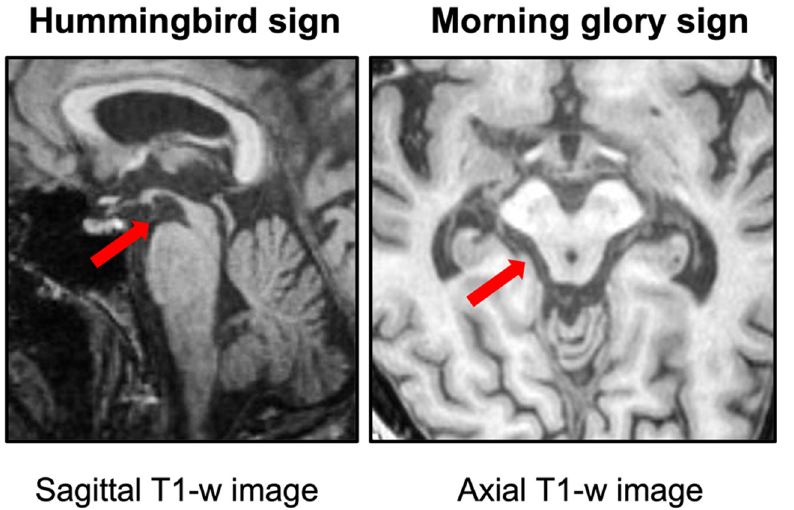
Figure 1. On the left, a T1-weighted midsagittal MR image showing the hummingbird sign with atrophy of the dorsal midbrain (red arrow) and relative sparing of the pons in a patient with progressive supranuclear palsy. On the right, a T1-weighted axial MR image showing the Morning Glory sign with concavity of the lateral margin of the midbrain tegmentum (red arrow) in a patient with progressive supranuclear palsy.